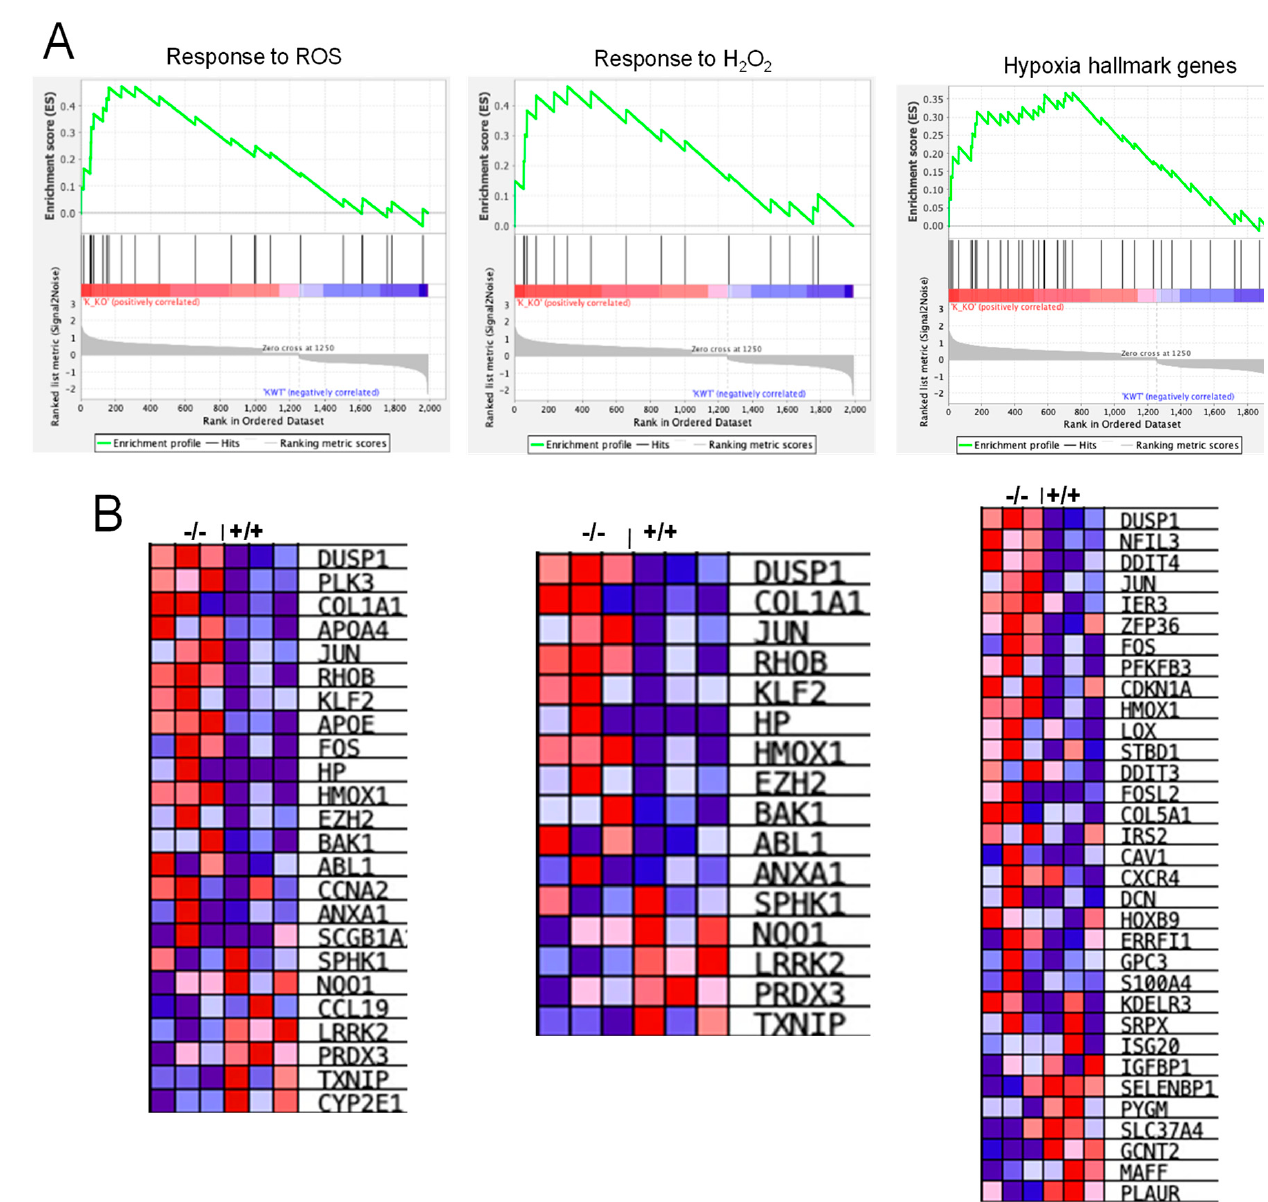
Figure 6. Cldn17 loss modulates the expression of genes regulating oxidative stress. ( A ) Gene enrichment plots (GO) and ( B ) heat maps (GSEA) depicting modulation of genes related to ROS, H 2 O 2 , and hypoxia in kidney samples from Cldn17 − / − mice against the WT group on RNA sequencing. Data represented for genes with fold-change >2; n = 3.